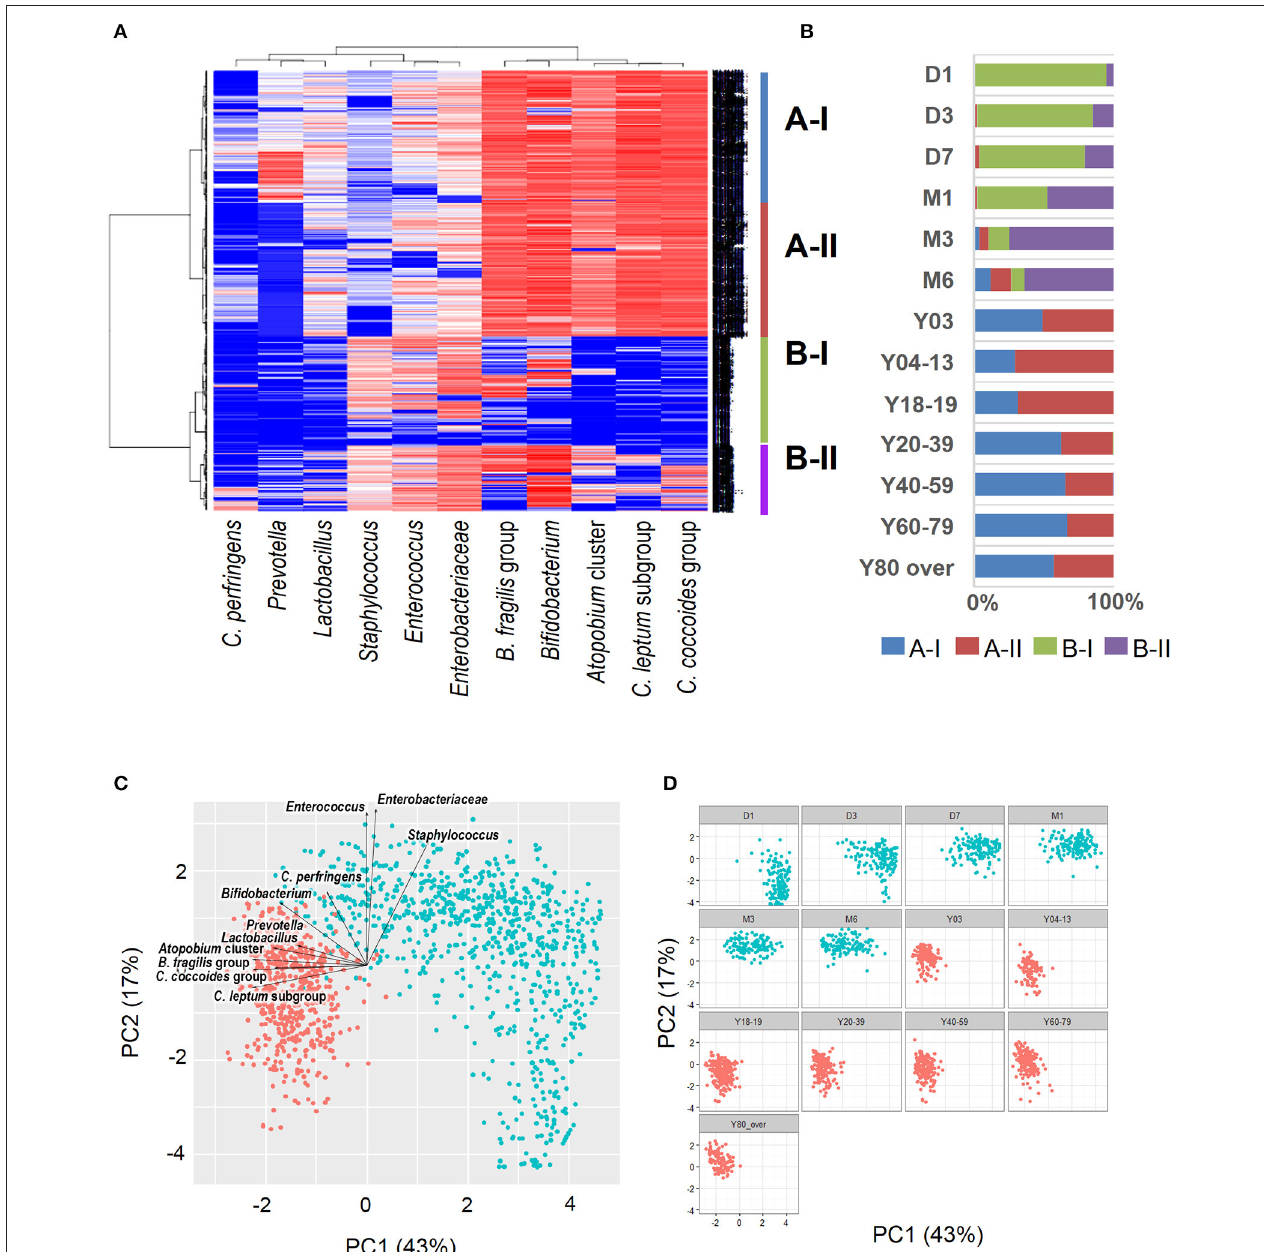
FIGURE 2 | Heat-map analysis (A) , classification by hierarchical clustering (B) , and principal component analysis plots ( C : all subjects; D : age-wise) of intestinal bacterial microbiota in healthy Japanese volunteers ( n = 1951). Red dots indicate infant type of microbiota (day 0 to age 6 months) and blue dots indicate adult type (3 years to over 80 years). Arrows indicate characteristic vectors of the factor loadings of 11 bacterial